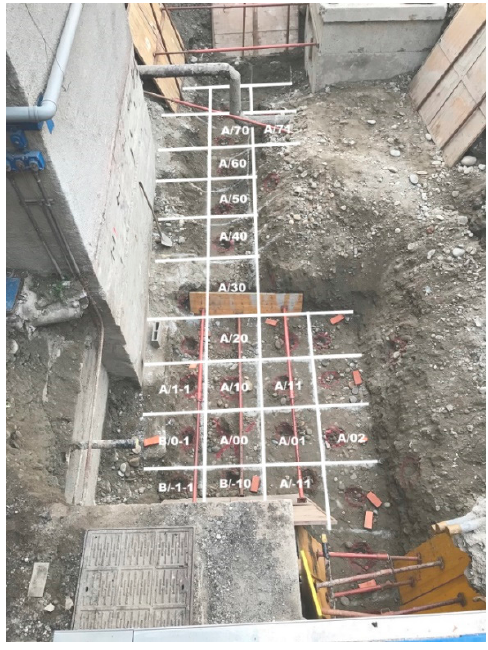
Figure 9. Contaminated area. Table 5. Cementitious and various materials clearance levels. Ministerial Decree 12 August 2009. Technical management prescriptions.